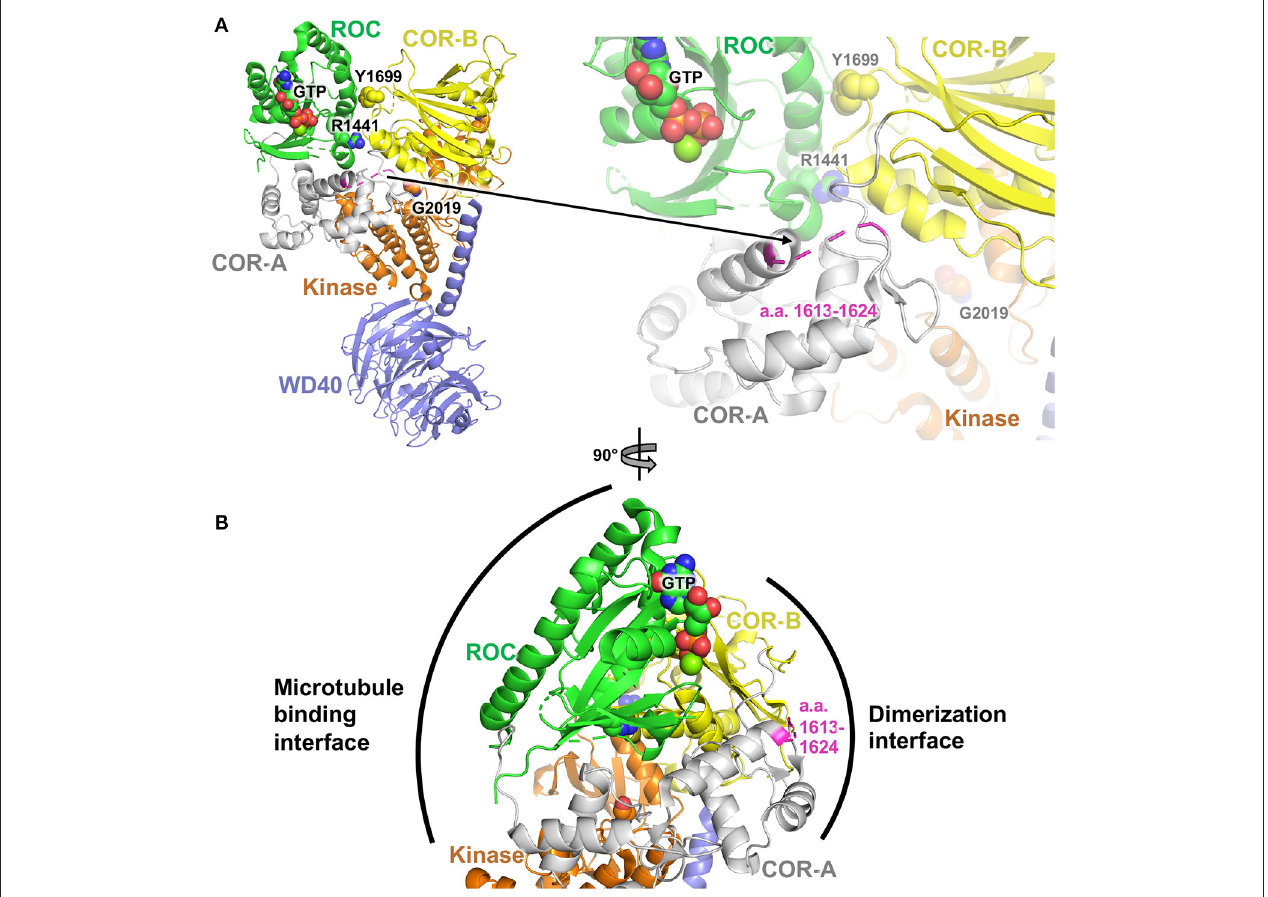
FIGURE 1 | Structural analysis of PD variants in LRRK2. (A) Cryoelectron microscopy structure of Lrrk2 C-terminal domains, PDB code 6vp6 (102). Parkinson-linked missense mutation sites R1441, Y1699, and G2019 are shown as spheres. The loop spanning a.a. 1612–1624 in the COR-A domain is shown in magenta. (B) Rotated view (90 ◦ ) of the structure in (A) , showing the proposed dimerization and microtubule binding interfaces, based on integrative modeling of Lrrk2 filaments bound to microtubules (